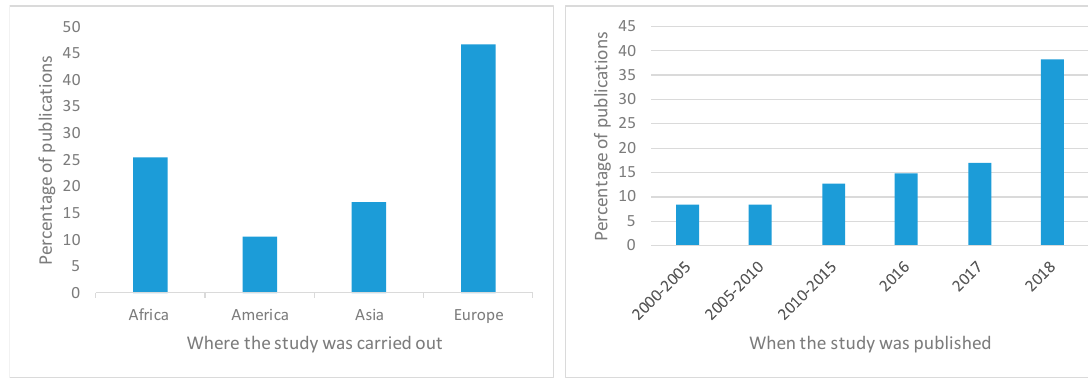
Figure 2. Repartition of studies included in the meta-analysis per continent and per year of publication. Figure 3. Forest plots of the differences in means of the average daily gain (left panel), feed intake (middle panel), and feed conversion ratio (right panel) between poultry fed a diet with and without insects.